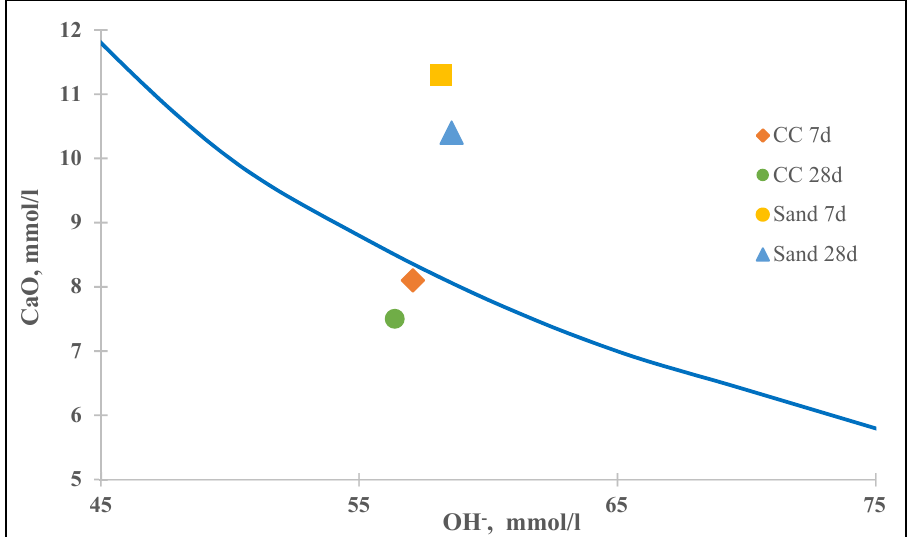
Figure 6. Frattini test showing the reactivity of the calcined clay.